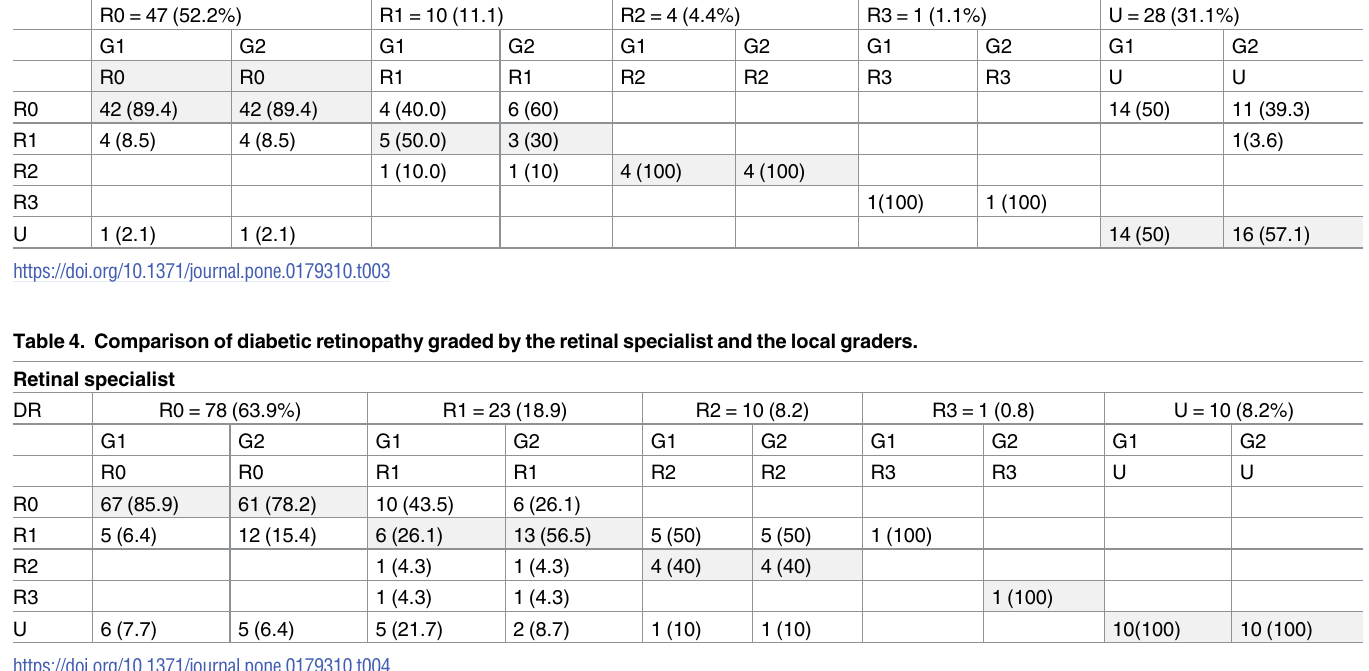
was very strong (0.94). For maculopathy, the intra-class correlation was between 0.78 to 0.84 among the CERA grader, the RS and the local graders (Tables 7 and 8). before training and 80% (93%) after training. Sensitivity (specificity) between the CERA grader